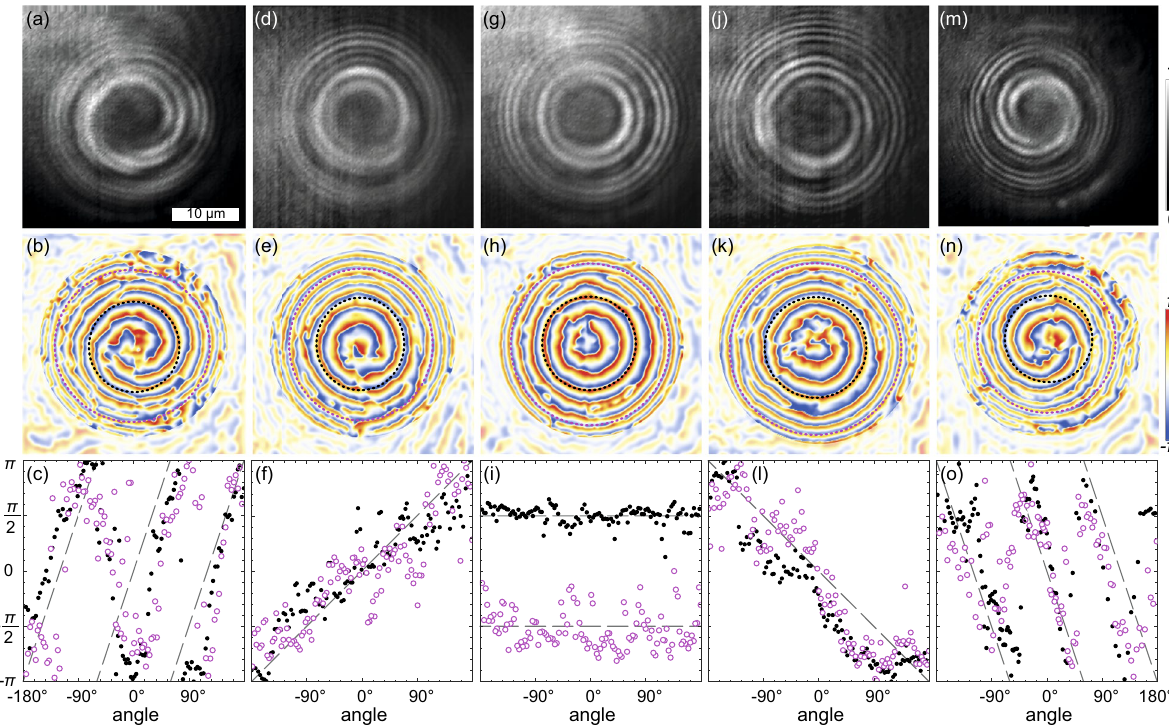
Figure 2. Observation of concentric ring polariton condensates that either contain ( a – f , j – o ) or do not contain ( g – i ) azimuthal currents. Top panels show interferometry images obtained from the interference of PL of the condensates in the pillar microcavity and the spherical reference wave in the Mach-Zehnder interferometer. Middle panels show the phase of the condensates relative to the phase of the reference wave extracted from the corresponding interferometry images. Bottom panels show the phase variation along the maxima of the condensate rings (indicated by black and magenta dashed curves in middle panels). In bottom panels, the dashed lines are guides for the eye corresponding to the linear variation of the phase ϕ with the azimuthal 0, 1 and 3. The coordinate origin 0 m θ const . with m angle θ , ϕ ◦ was chosen arbitrary to minimise the = + | | = number of breaks of the dependence ϕ(θ) .